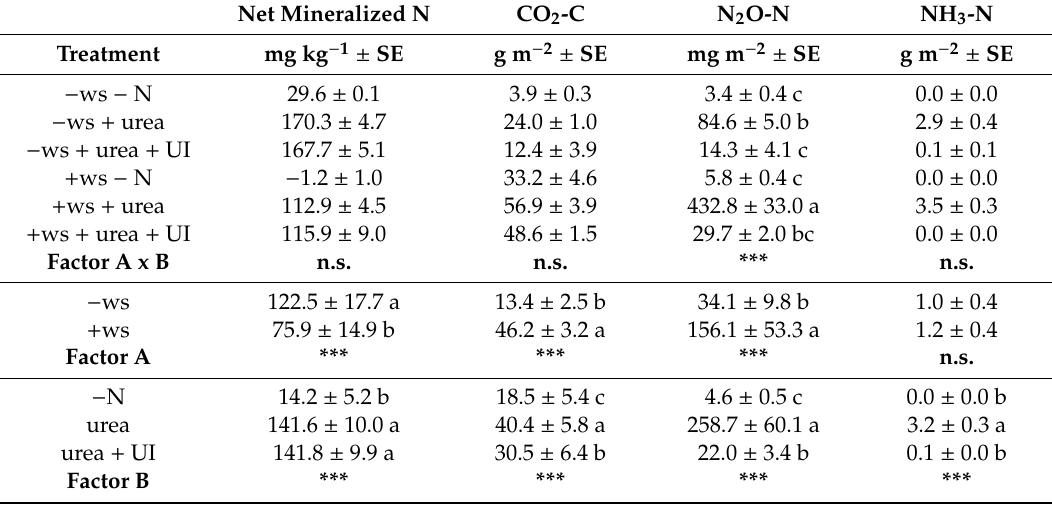
Table 2. Apparently net mineralized N (NH 4 -N + NO 3 -N), total CO 2 -C respiration, total N 2 O-N emission and total NH 3 -N volatilization at the conclusion of the experiments (2 weeks), showing the main e ff ects of the 2-factorial experimental design (wheat straw x fertilizer) in the two experiments (Exp. 1 and Exp. 2). Letters behind values indicate significant di ff erences between treatments for either the main factors or, where relevant, the interaction between main factors of the experiment. Net Mineralized N CO 2 -C